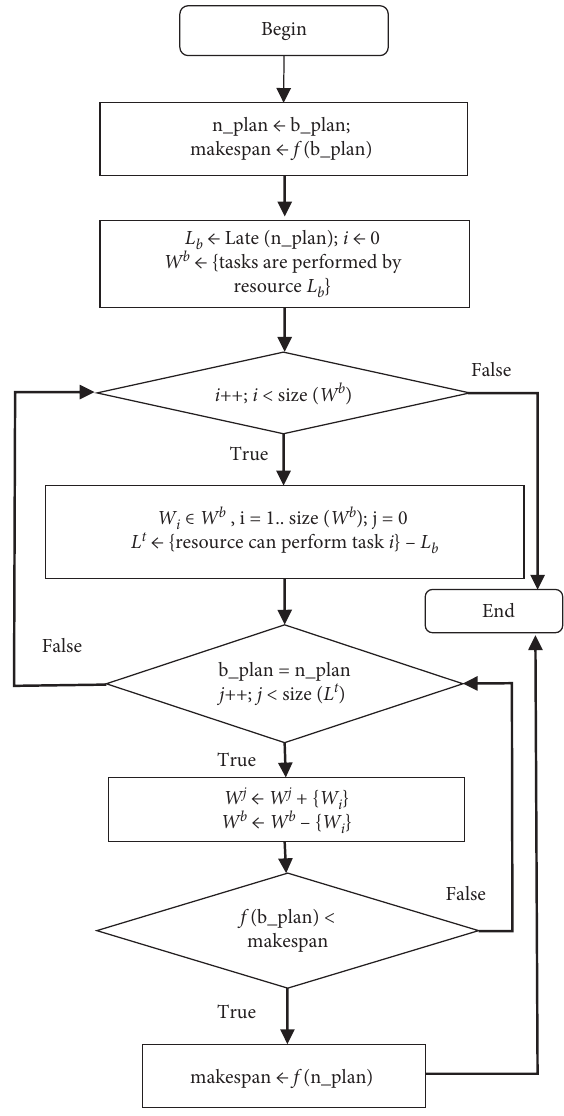
Figure 3: Function